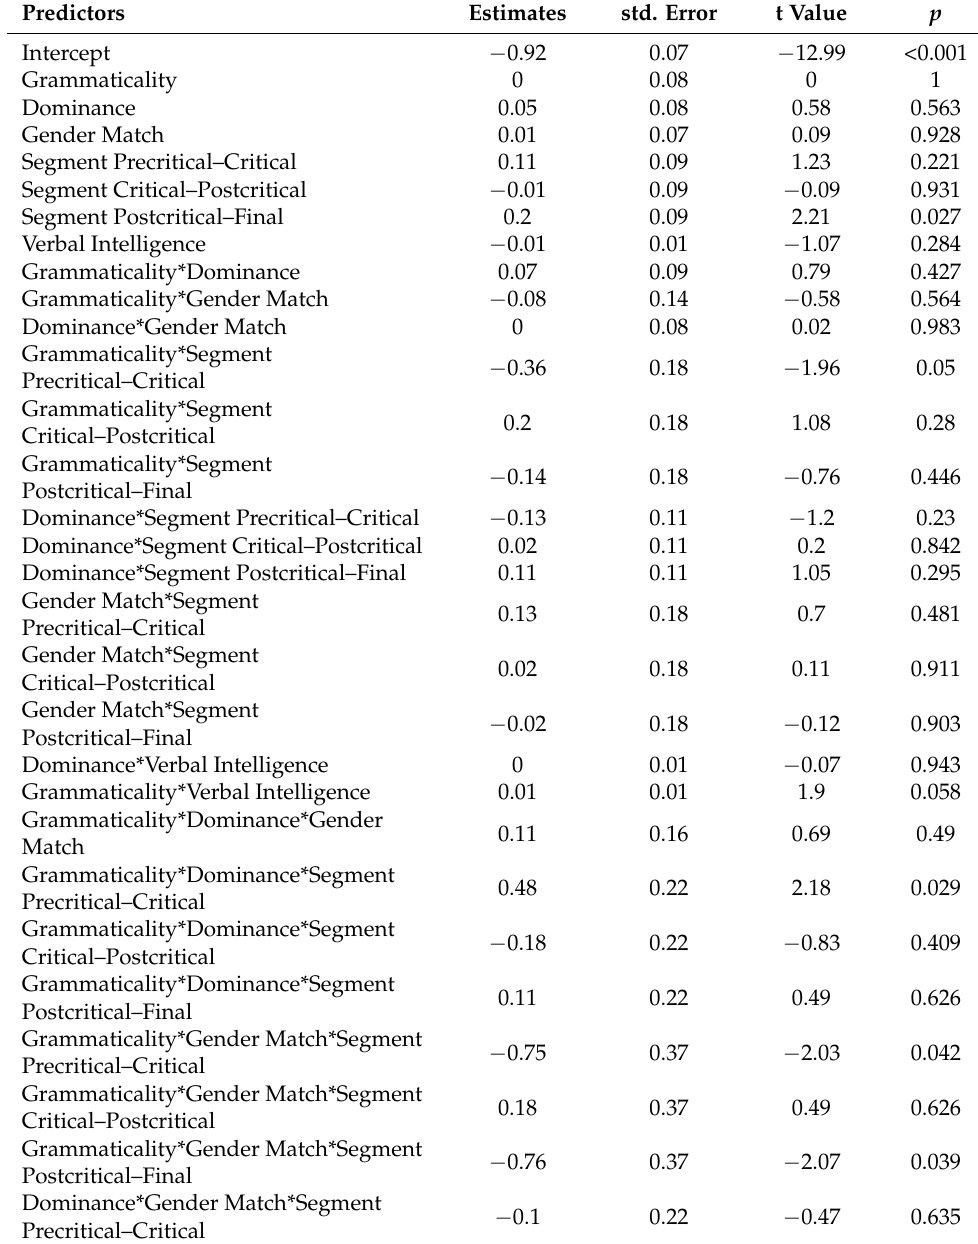
Table A14. Summary of the model with the bilingual children and verbal intelligence and dominance as